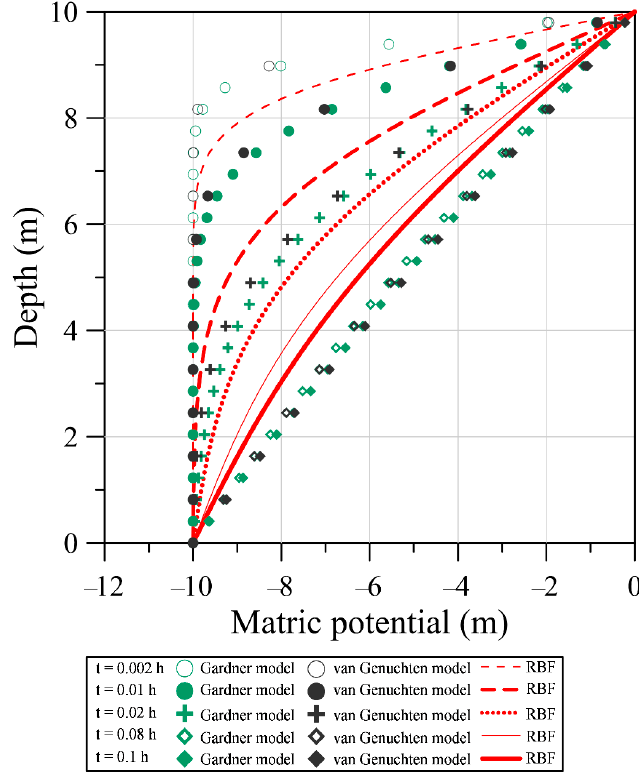
Figure 14. Computed matric potential.